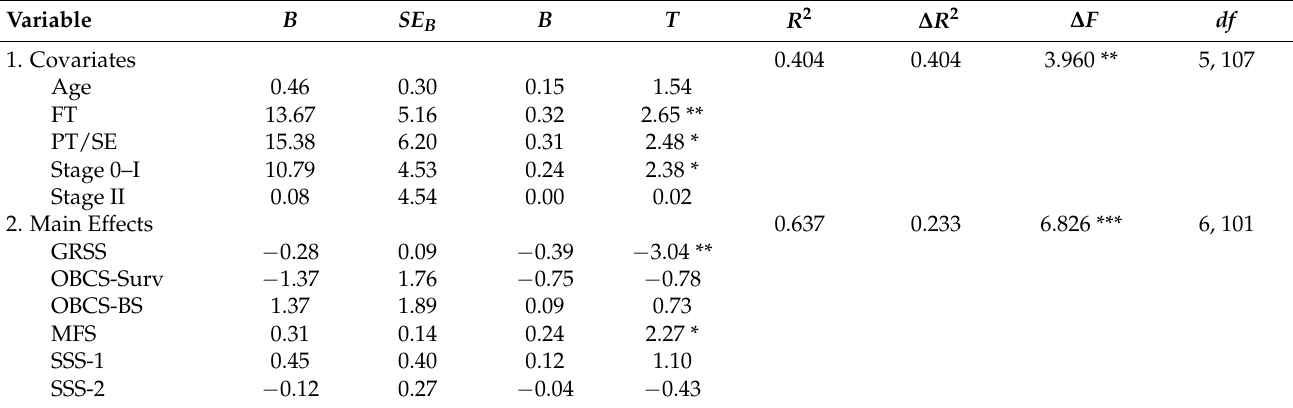
Table 4. Hierarchical regression analysis for gender socialization variables predicting FACT-B